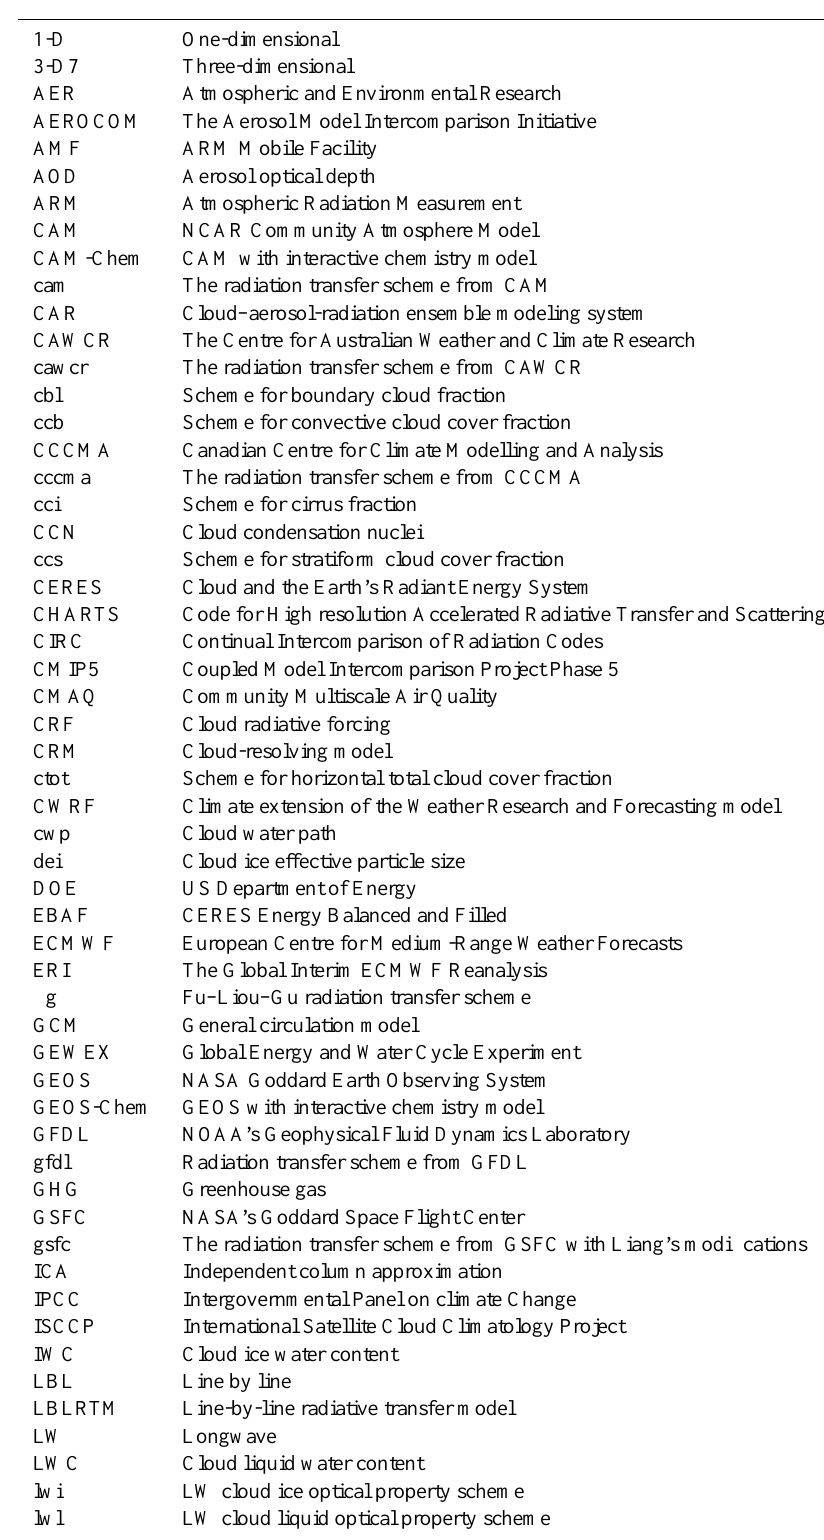
Table 5. Abbreviations and